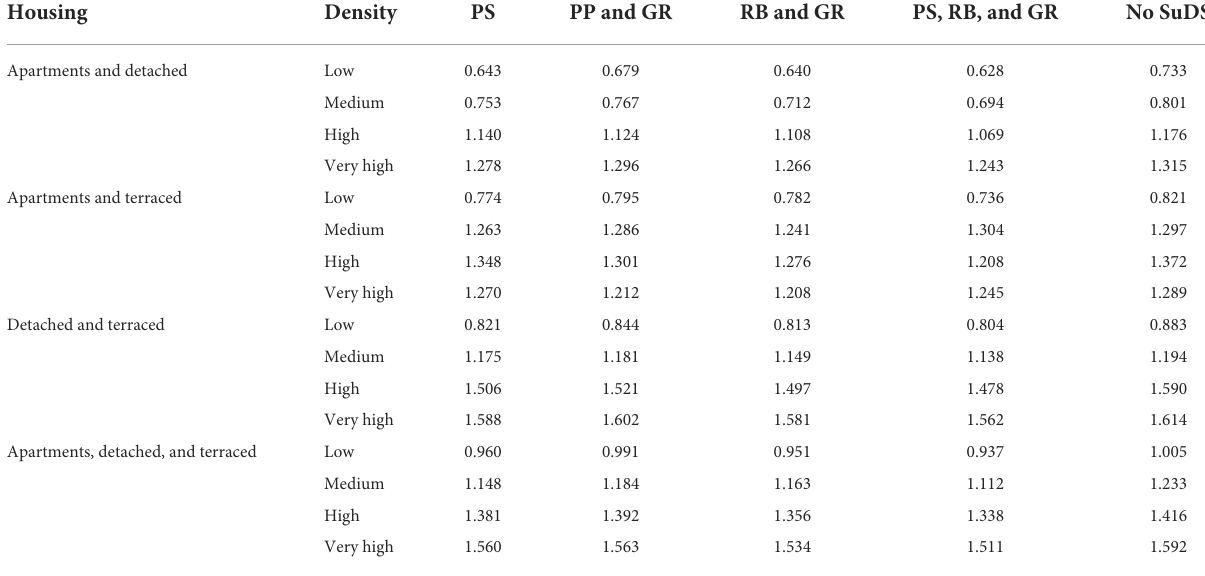
TABLE 2 Optimal pipe diameter (m) required under each SuDS scenario for the development tiles to fully capture a 2h duration 1-in-10 year rainfall event. Housing Density PS PP and GR RB and GR PS, RB, and GR No SuDS Apartments and detached